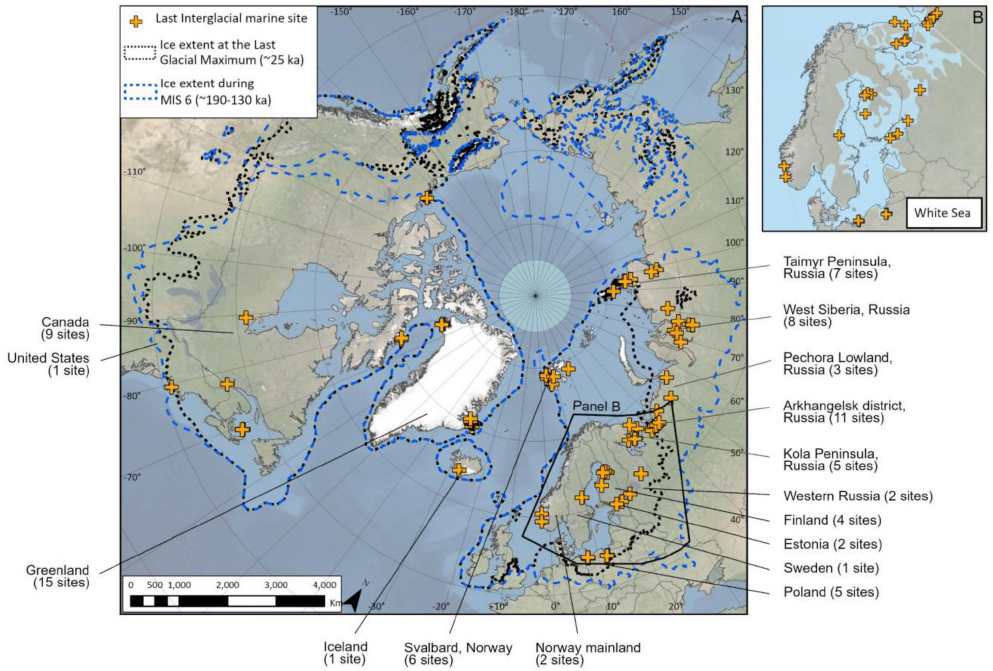
Figure 1. Location of last interglacial (LIG) marine sites in the formerly glaciated Northern Hemisphere, along with the extent of MIS 6 and Last Glacial Maximum ice sheets (Batchelor et al., 2019). Inset map shows the extent of the LIG White Sea that inundated the isostatically depressed landscape of western Russia and north-western Europe. Base layer: ArcGIS World Imagery.